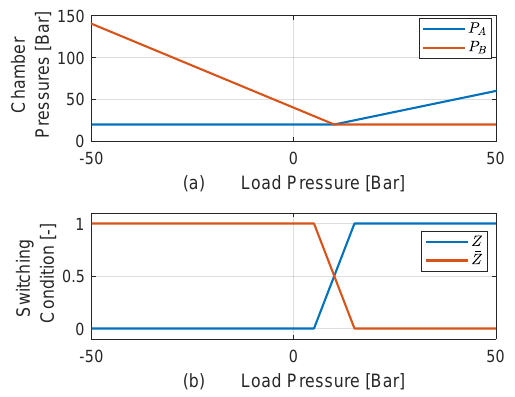
Figure 5: (a) Ideally controlled chamber pressures as a function of load pressure for p set = 20 bar and α = 0 . 5. (b) Input transformation switching variables as a function of load pres- sure for Z band = 5 bar